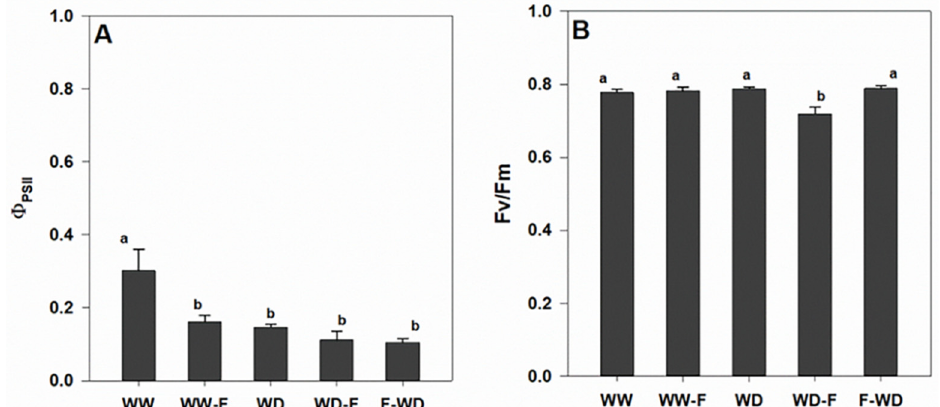
Figure 4. ( A ) Midday quantum yield of PSII photochemistry ( ɸ PSII) and ( B ) maximum quantum yield of PSII photochemistry (Fv/Fm) of grapevines exposed to WW (well-watered control); WW-F (well-watered fungal inoculation); WD (water deficit); F-WD (inoculation before water deficit); WD-F (inoculation after water deficit). Different lowercase letters indicate significant differences among the five treated groups ( p ≤ 0.05).